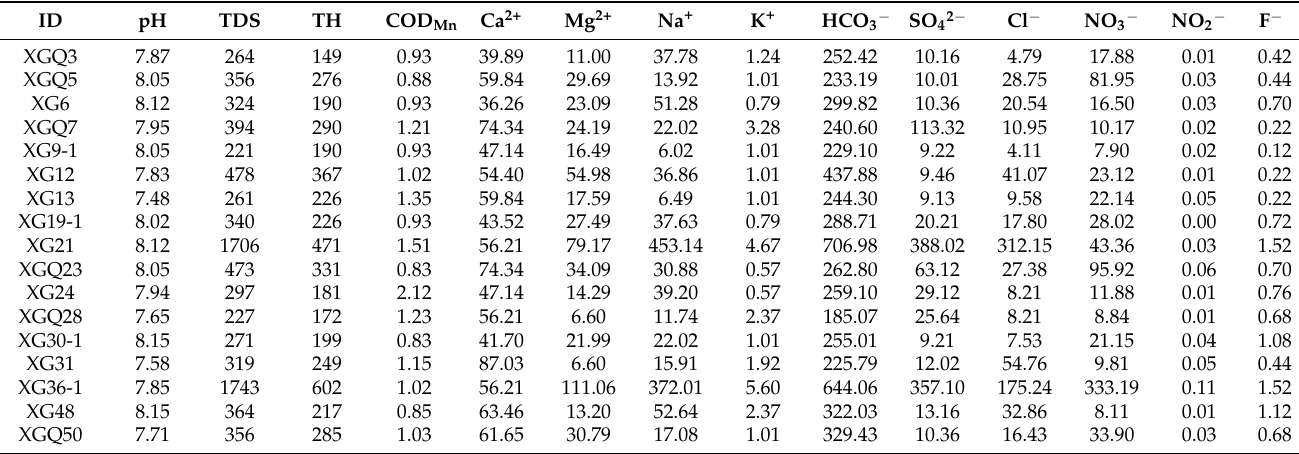
Table 1. General information of